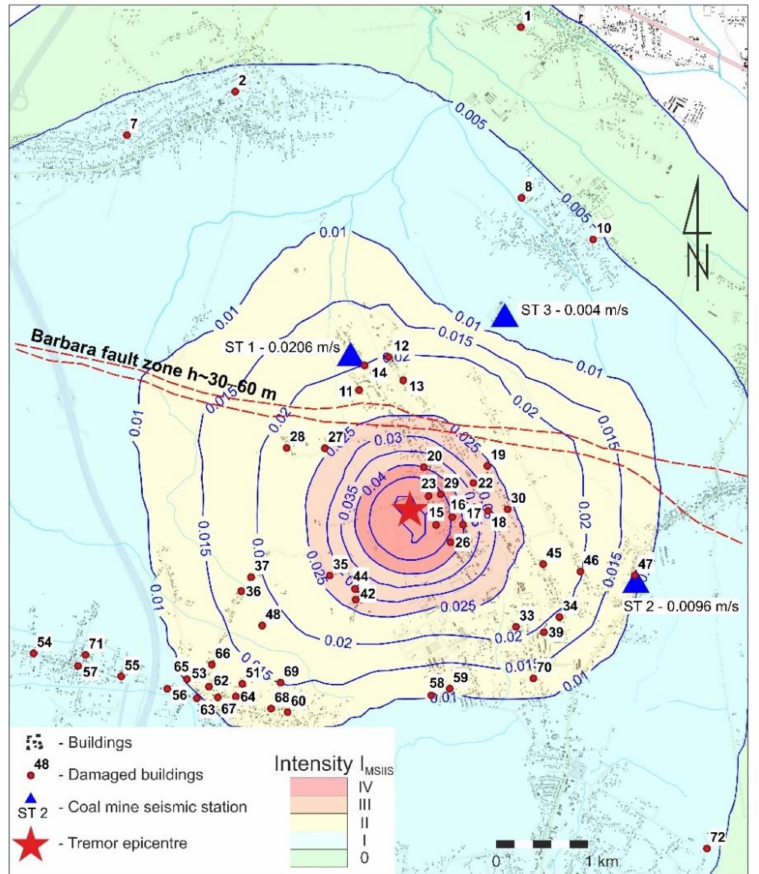
Figure 7. The predicted isoline map of PGV Hmod with degrees of ground vibration intensity I MSIIS and location of damaged buildings for the tremor of 8 November